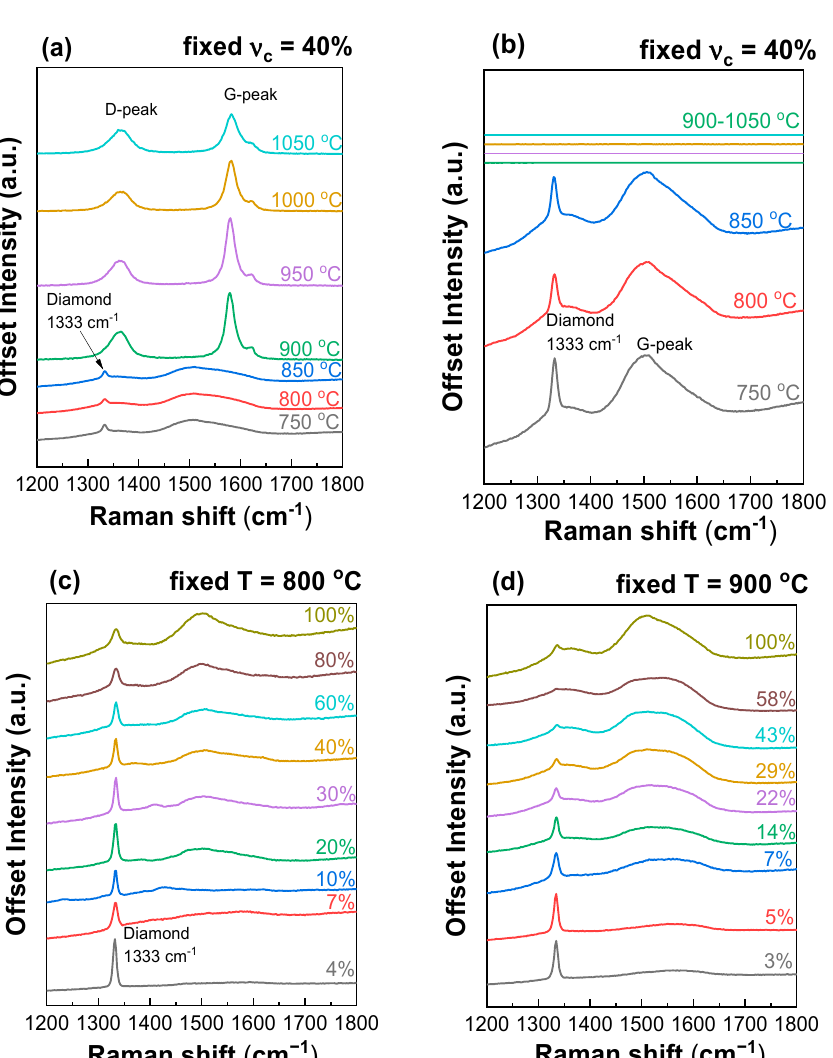
Figure 5. ( a , b ) Raman spectra of polycrystalline diamond films synthesized at fixed CH 4 to total flow concentration 𝜈 𝑐 = 40% and different substrate temperatures before ( a ) and after ( b ) air anneal. ( c , d ) Raman spectra of polycrystalline diamond films synthesized at 800 ± 25 °C ( c ) and 900 ± 25 °C ( d ) and different 𝜈 𝑐 concentrations.